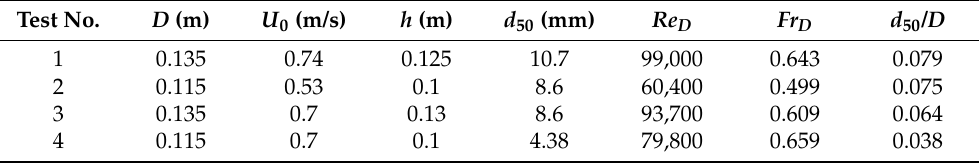
Table 2. Experimental conditions from [28] used for validation. Test